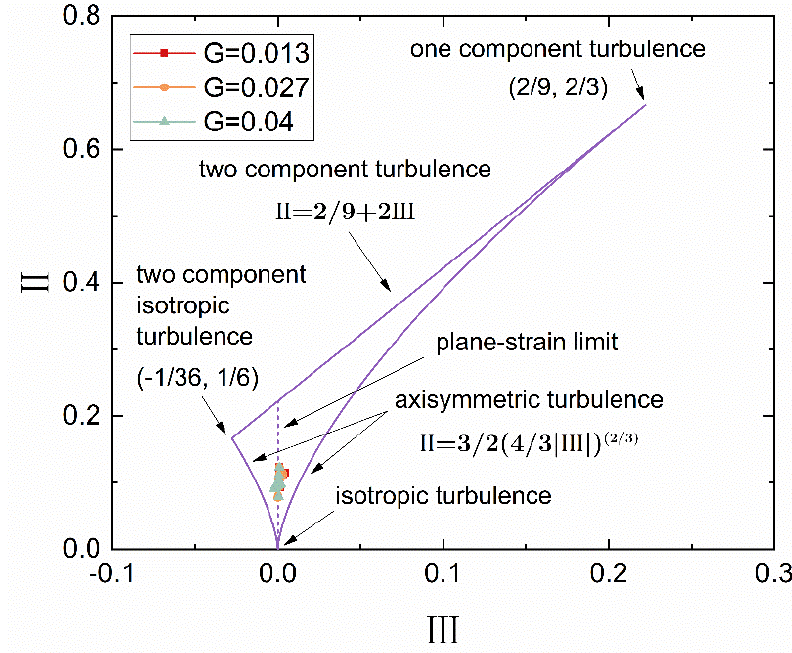
Figure 8. The anisotropy invariant map.